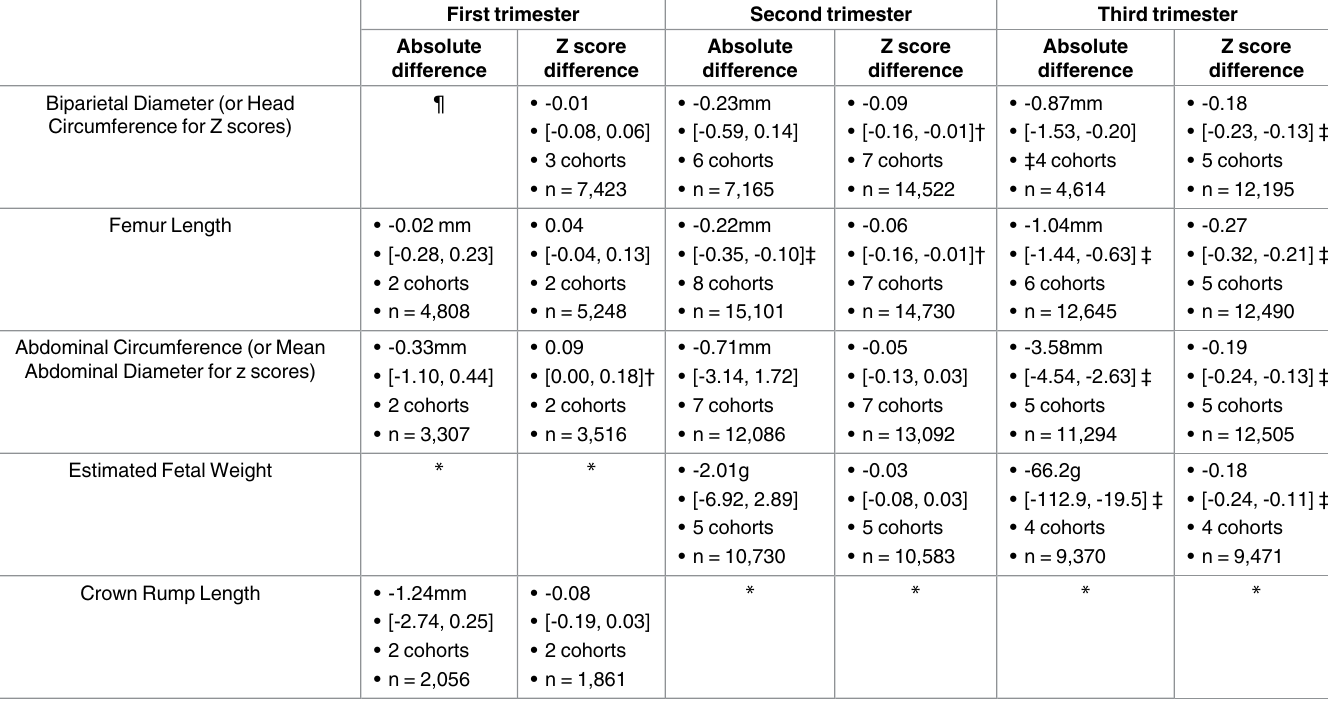
Table 3. Summaryof meta-analyses relating maternal smoking to absolute and standardised second and third trimester fetal